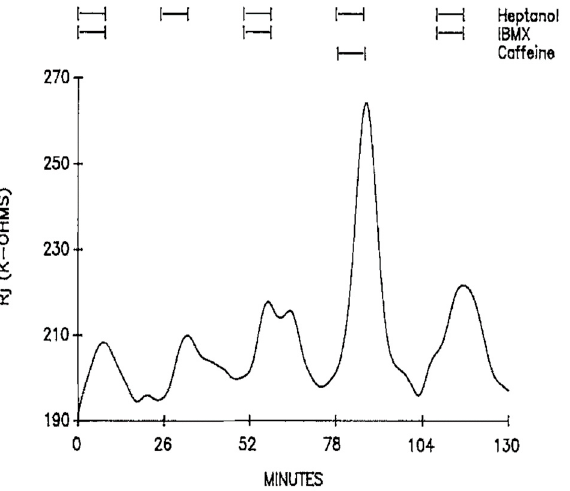
Figure 7. Time course of Rj in crayfish axons uncoupled by heptanol in the presence and absence of 1 mM IBMX. IBMX (an inhibitor of phosphodiesterases and adenosine receptors) does not affect heptanol-induced Rj rise. Adapted from [16] .